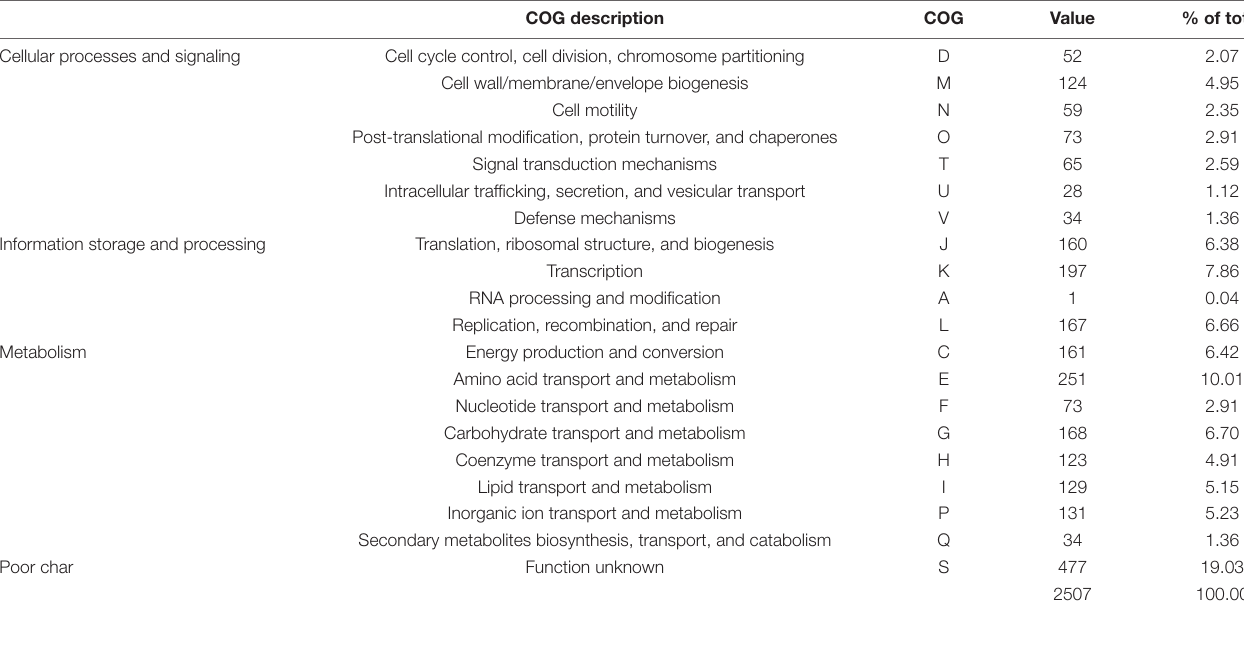
TABLE 3 | Clusters of Orthologous Groups of proteins (COG) classification of the annotated genes in A. mali FL18. COG description COG Value % of